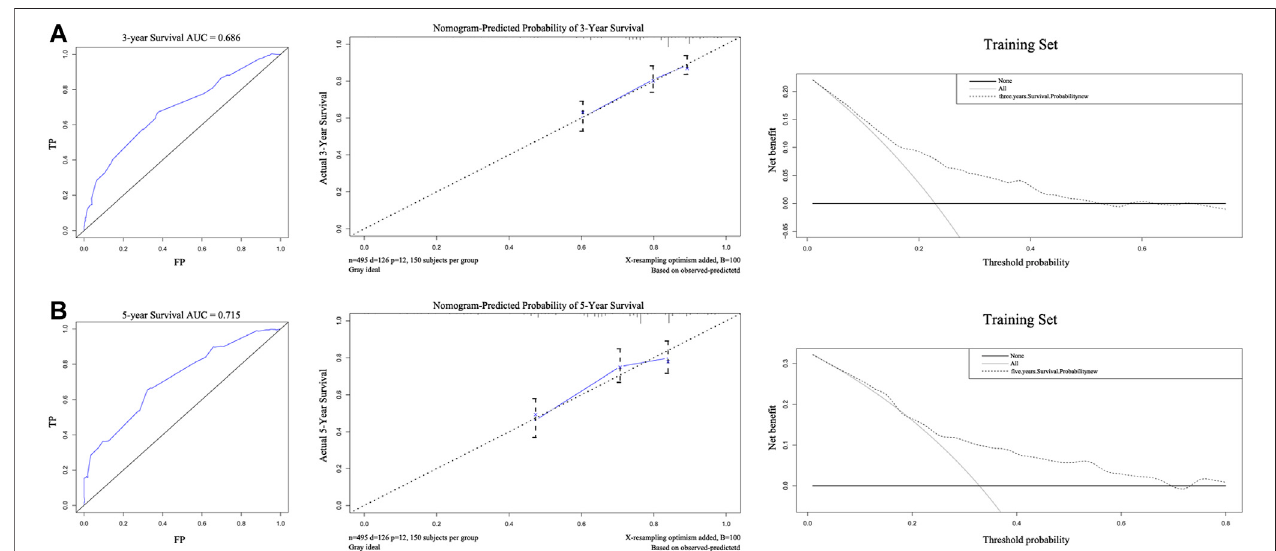
FIGURE 3 | The areas under the receiver operating curves, Calibration plots, and decision curve analysis of OS associated nomograms in training set. The training set of 3-years (A) and 5-years (B) , respectively.